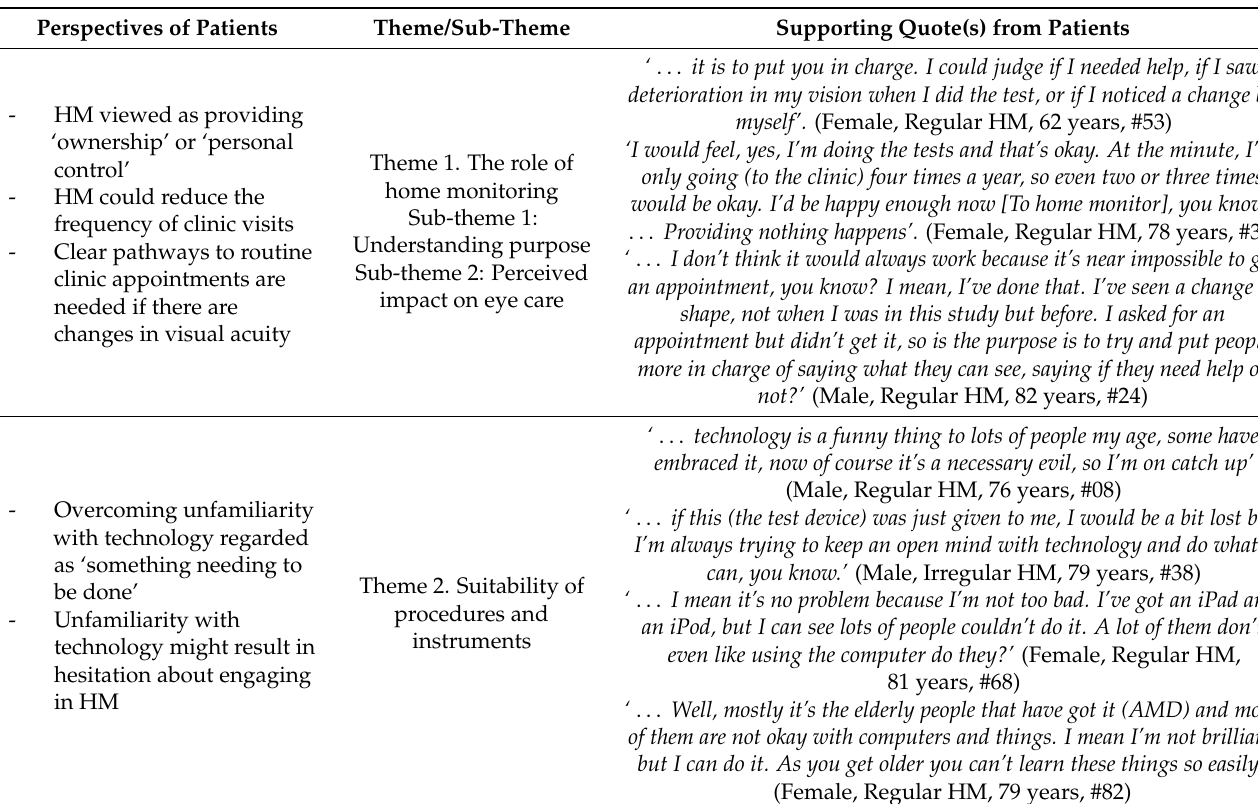
Table 3. Perspectives of patients on acceptability of home